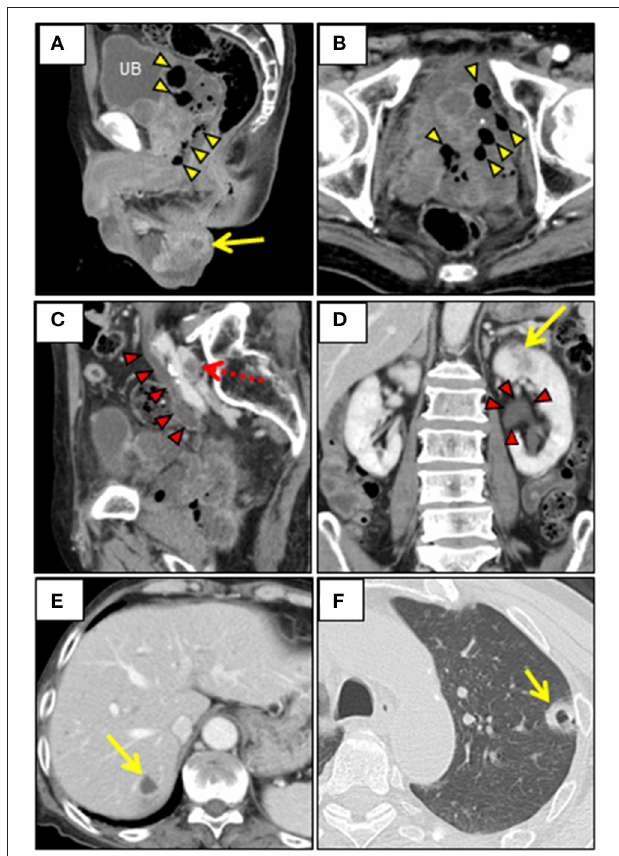
FIGURE 2 | Contrast-enhanced whole-body CT. (A, B) Pelvic CT reveals the irregularly-shaped enlarged prostate and the left seminal vesicle, which are replaced by encapsulated fluid cavities containing multiple gas bubbles (arrowheads), with spread of infection into extraperitoneal perivesicular space in the small pelvis. Note the left epididymal abscess (arrow). (C, D) Abdominal/pelvic CT shows marked dilatation of the left ureteral and renal pelvis (arrowheads), and multiple hypoenhancement foci in the left renal parenchyma (arrow). Note the thrombus in the left common iliac vein parallel to the dilated ureter (dotted arrow). (E) Abdominal CT reveals a centrally hypoattenuating lesion with peripheral heterogeneous enhancement in liver S7 (arrow). (F) Chest CT (lung window) reveals peripheral thick-walled cavitary nodule in the left upper lobe (arrow). CT, Computed tomography; UB, Urinary